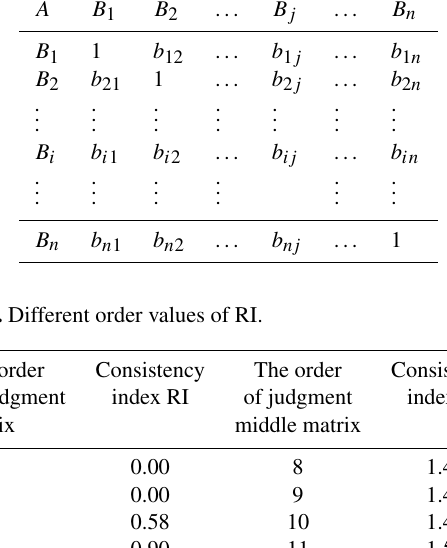
Table 2. Standard table of multiple comparison. Scale